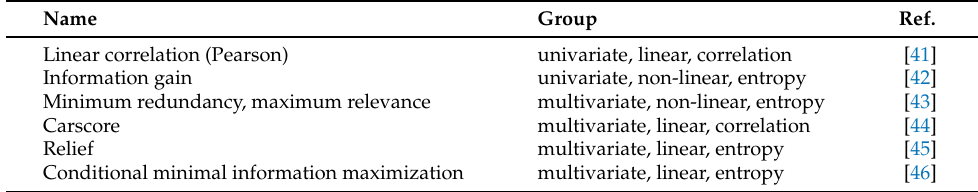
Table 2. List of filter methods used in this work, their categorization, and scientific